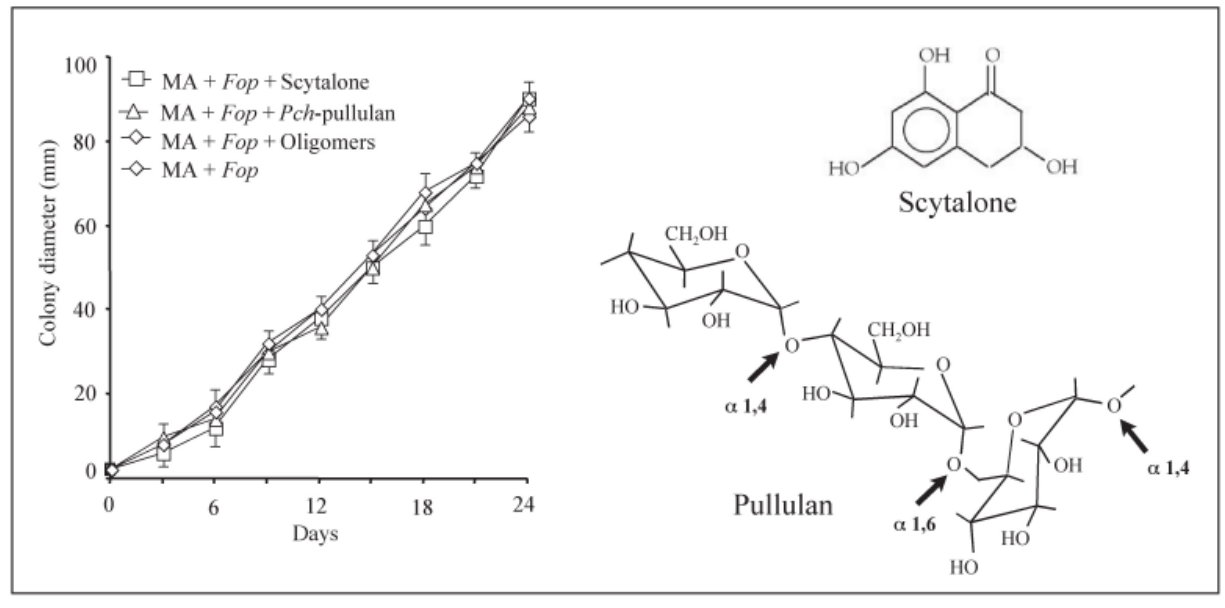
Fig. 4. Effect of scytalone (1 mg ml -1 ), pullulan produced by Phaeomoniella chlamydospora ( Pch ) (0.2 mg ml -1 ) and oligomers obtained by enzymatic digestion of Pch- pullulan (2 mg ml -1 ) on the growth of Fomitiporia punctata ( Fop ) . Standard error bars are